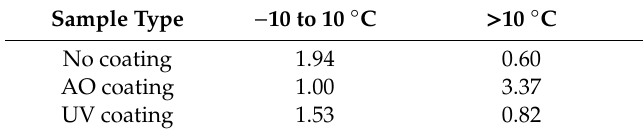
Table 5. Comparison of the di ff erence in CTE between ground and in-orbit